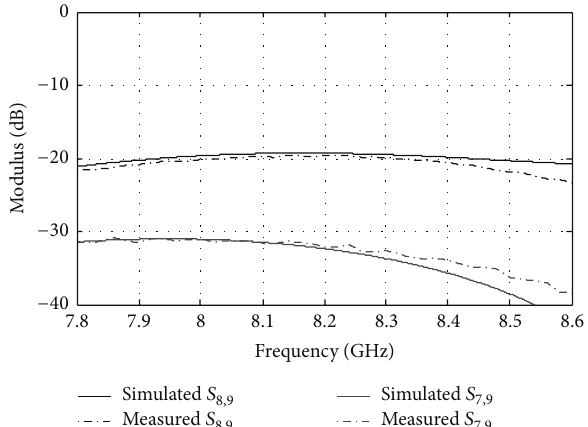
Figure 6: Simulated and measured coupling coefficients from the central pixel to first left neighboring one ( 𝑆 8,9 ) and to second left neighboring one ( 𝑆 7,9